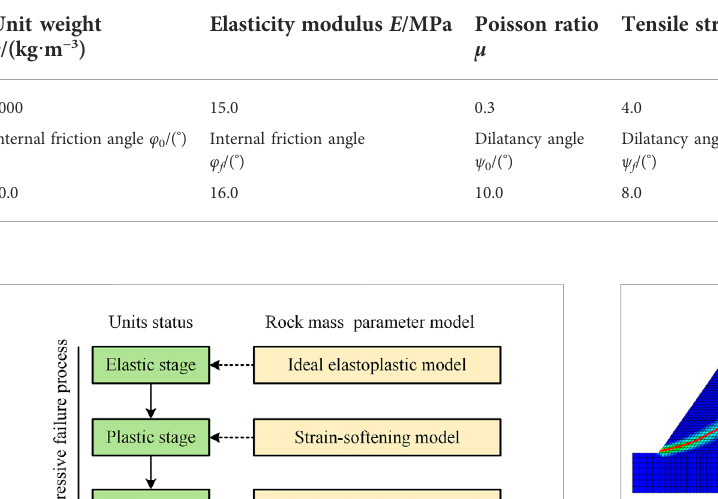
FIGURE 8 Critical slip surface obtained by dichotomy